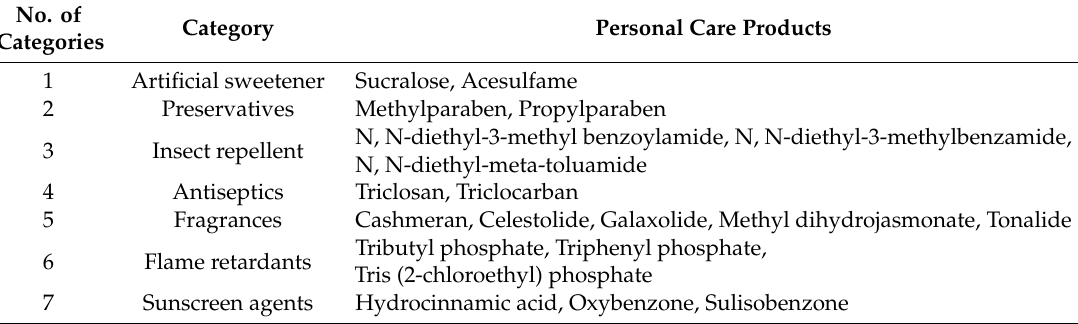
Table 2. Studied 20 personal care products (PCPs) categorized according to their